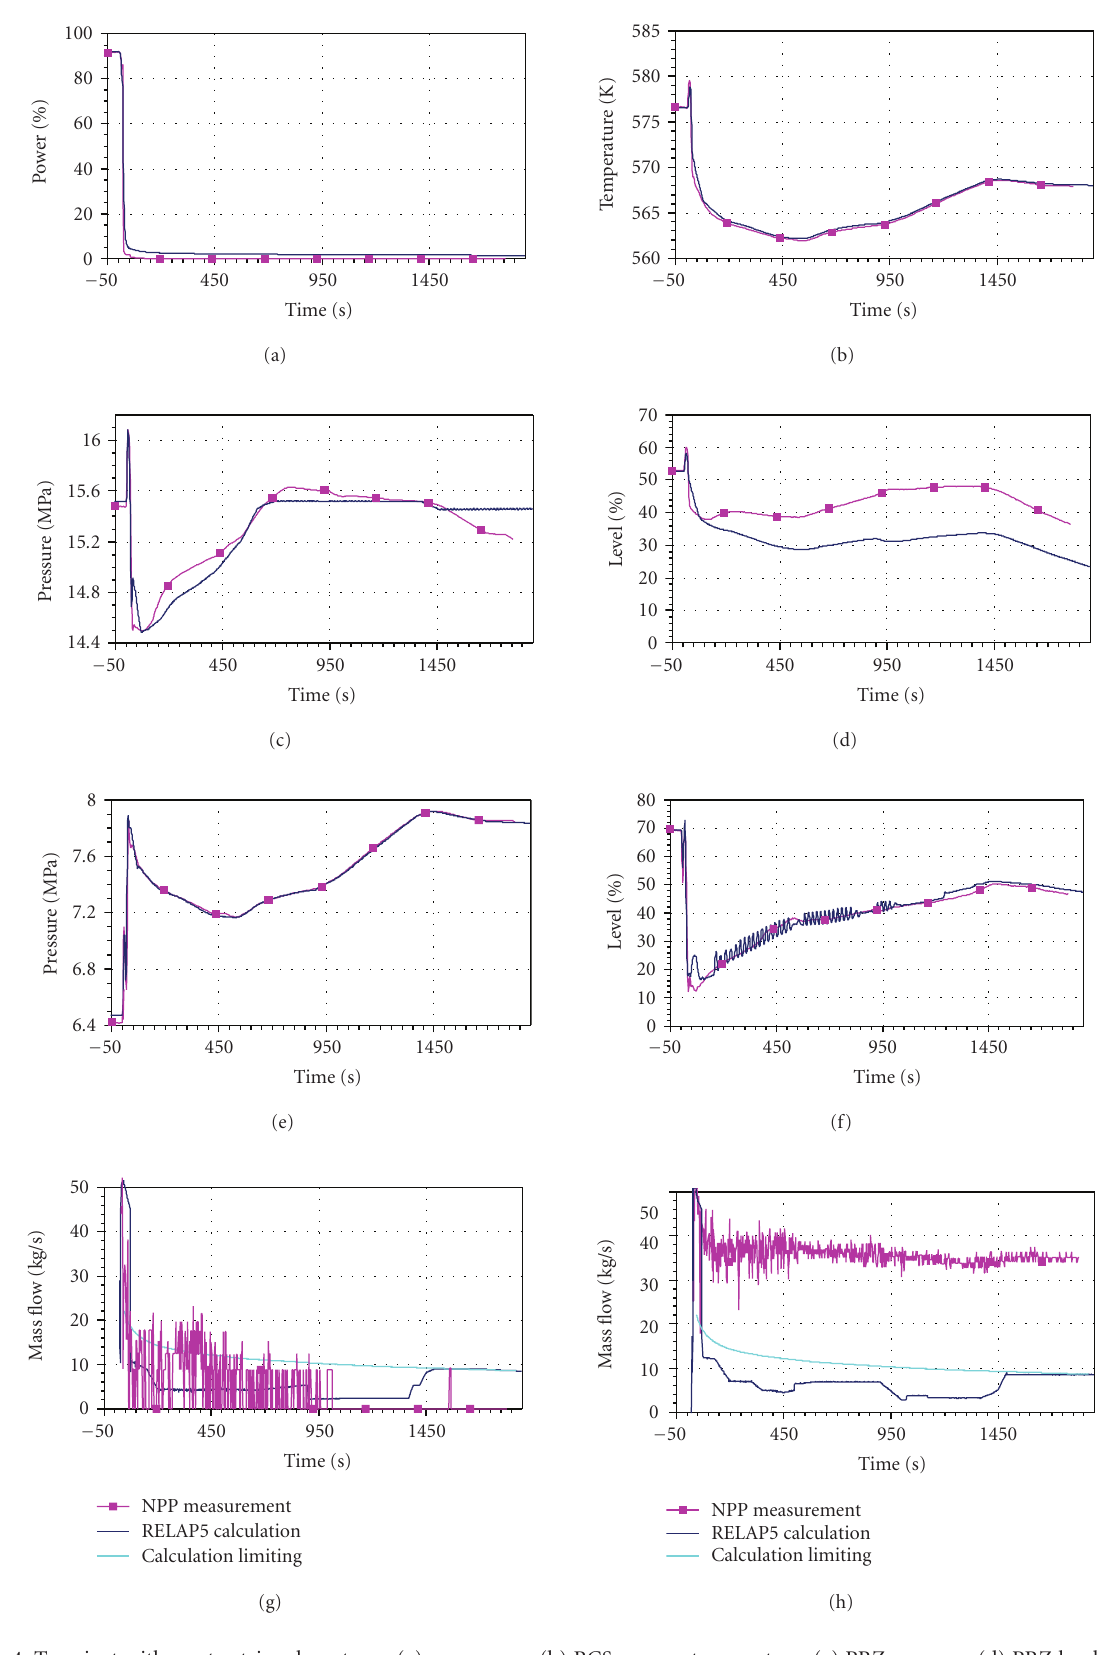
Figure 4: Transient with reactor trip—long term: (a) core power, (b) RCS average temperature, (c) PRZ pressure, (d) PRZ level, (e) SG 1 pressure, (f) SG 1 NR level, (g) SG1 steam flow, (h) SG2 steam